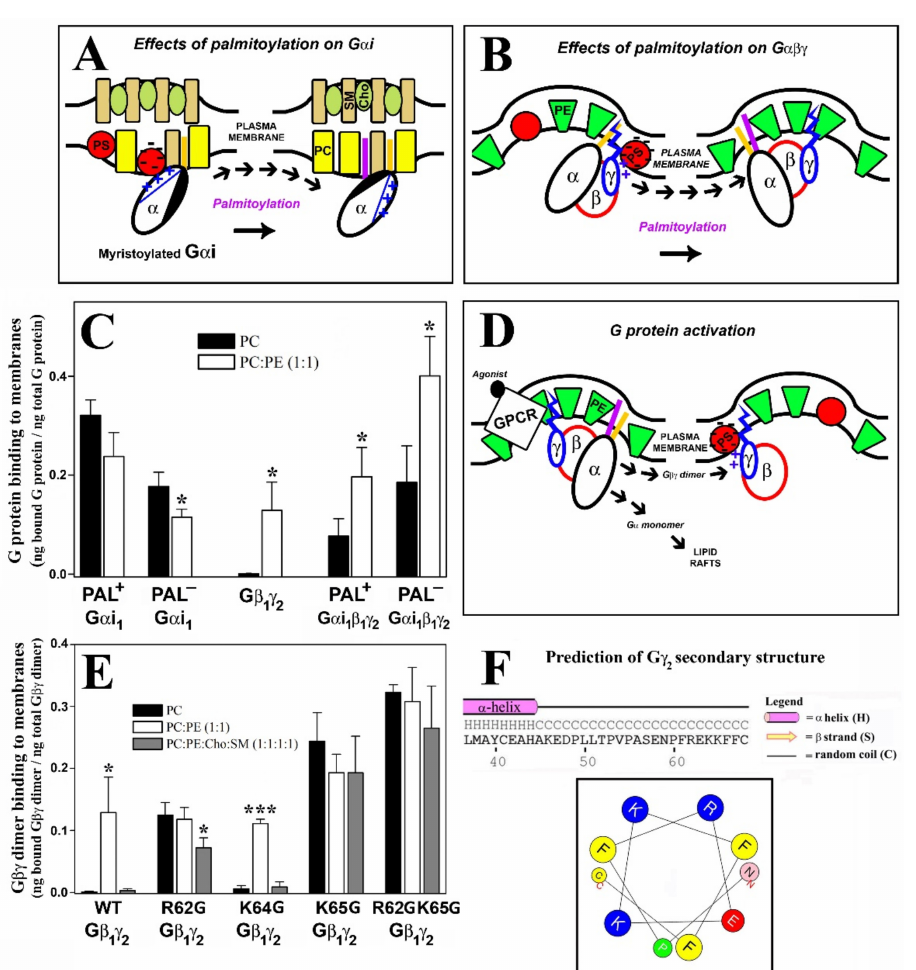
Figure 9. Key molecular determinants of G α i1 β 1 γ 2-membrane interactions and models to explain the G protein-lipid membrane interactions. ( A ), Model to explain the interaction between G α i1 and membrane lipids. A reorientation of the N-terminal α helix of G α i1 by reversible palmitoylation of the protein drives its redistribution in the plasma membrane, moving it from PS-rich toward PS-poor raft-like microdomains. ( B ), Model to explain the G α i1 β 1 γ 2-membrane interactions depending on the palmitoylation status of the protein G complex. Localization of palmitoylated G α i1 β 1 γ 2 to PS-poor and PE-rich microdomains differs from the distribution of de-palmitoylated G α i1 β 1 γ 2 in PS- and PE-rich microdomains. ( C ), Graph showing the nonlamellar preference and the role of reversible palmitoylation in the basic mechanisms of G α i, G βγ and G α i βγ interactions with membrane lipids. Bars represent the binding of Pal+ G α i1, Pal − (C3S mutant) G α i1, WT G β 1 γ 2, WT G β 1 γ 2-Pal+ and WT G β 1 γ 2-Pal − G α i1 to PC and PC:PE (1:1, mol:mol) membranes. ( D ), Model of the activation of heterotrimeric G proteins that explains the interaction of G α i1 β 1 γ 2 with membrane lipids in the presence of GPCR and the migration of the G β 1 γ 2 dimer after its separation from G α . ( E ), Graph showing representative results of the WT and mutated G β 1 γ 2 dimer’s interactions with model membranes. Bars represent the binding of WT G β 1 γ 2, single mutants and the R6G2K65G G β 1 γ 2 mutant to PC, PC:PE (1:1, mol:mol) and PC:PE:Cho:SM (1:1:1:1, mol:mol) membranes to show the role of the γ 2-subunit C terminal amino acids in the G protein dimer interactions with lamellar- and nonlamellar-prone membrane microdomains. ( F ), Secondary structure predictions of the C- terminal region of G γ 2 using the Psi-Pred and HELIQUEST tools. A bi-dimensional projection of the hypothetical C-terminal α helix of G γ 2 is depicted considering the last 10 amino acids of the protein (N and C represent the N- and C-terminal amino acids of this region, which coincidentally coincide with the amino acids asparagine, N, and cysteine, C, respectively). In ( C , E ), the data represent the mean ± S.E.M.: *** p < 0.001; * p <